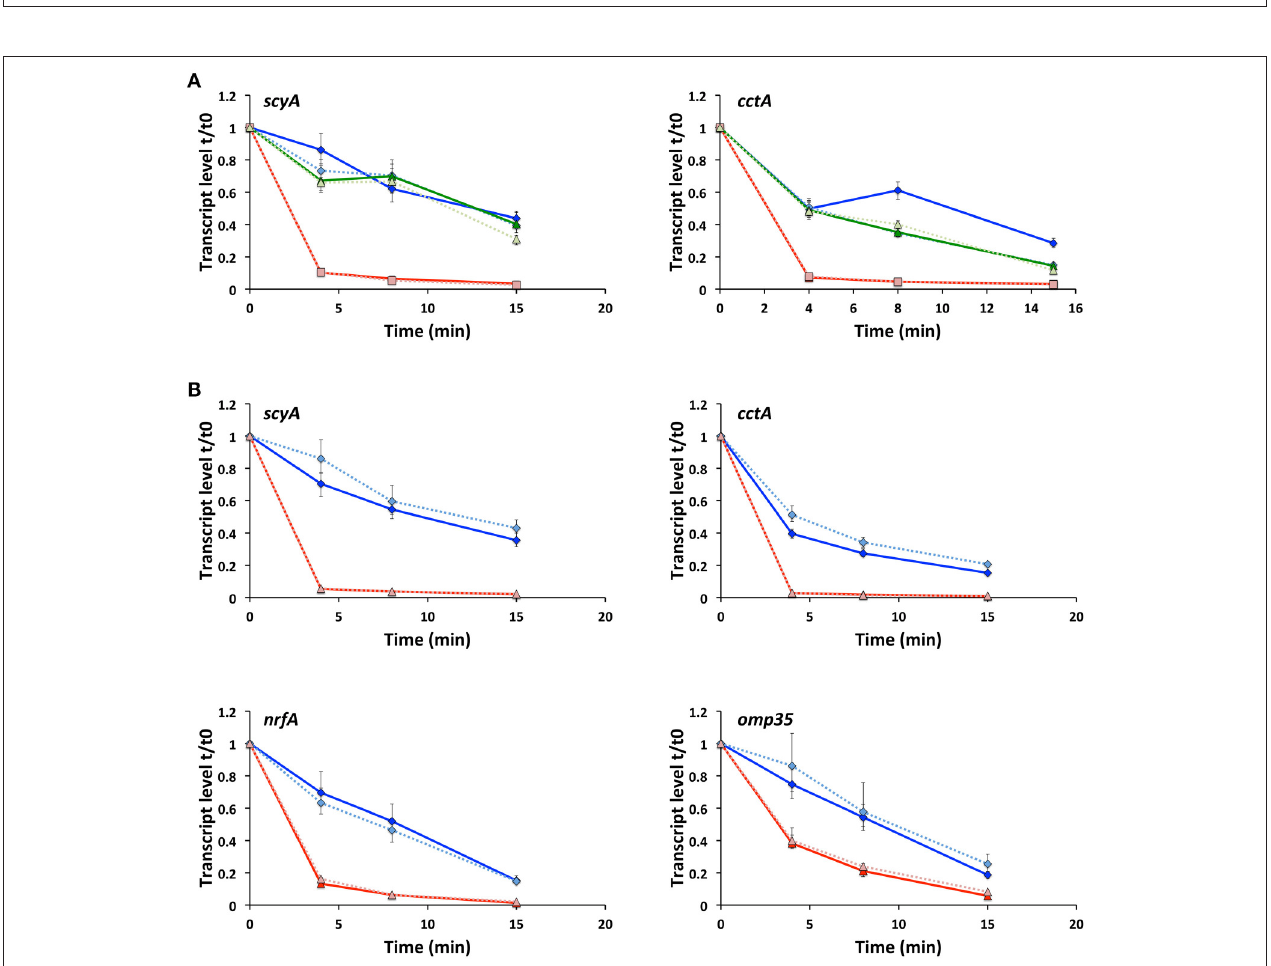
FIGURE 3 | Production of RyhB affects the stability of the target mRNA. (A) Transcript levels of scyA and cctA genes in the wild-type (blue diamonds), 1 fur (red squares) and 1 fur 1 ryhB (green triangles) strains at 0, 4, 8, and 15min after transcription was stopped. qRT-PCR was used to determine the transcript level relative to time 0, just before addition of rifampicin. Data shown are from two experiments; each with four replicate cDNA samples used in qPCR and shown as expression ratio ± standard error. For all strains, data from experiment 2 are depicted in lighter color and using a dashed line. (B) Transcript levels of scyA , cctA , nrfA , and omp35 genes at 0, 4, 8, and 15min after transcription was stopped in the 1 ryhB mutant containing an empty plasmid (pKM033) (blue diamonds) or a plasmid expressing RyhB (pKM033-ryhB) (red triangles). qRT-PCR was used to determine the transcript level relative to time 0, just before addition of rifampicin. Data are from two experiments; each with four replicate cDNA samples used in qPCR and shown as expression ratio ± standard error. For both strains, data from experiment 2 are depicted in lighter color and using a dashed line.